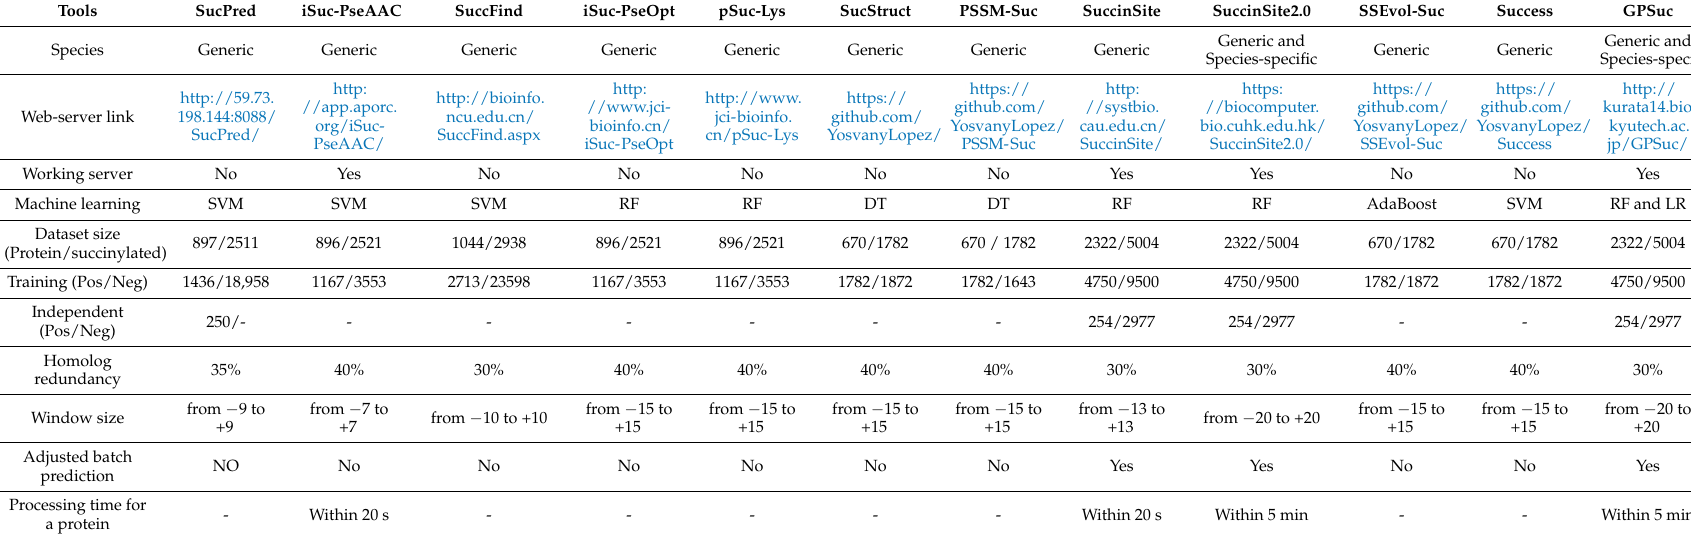
Table 1. Summary of the reviewed predictors for lysine succinylation